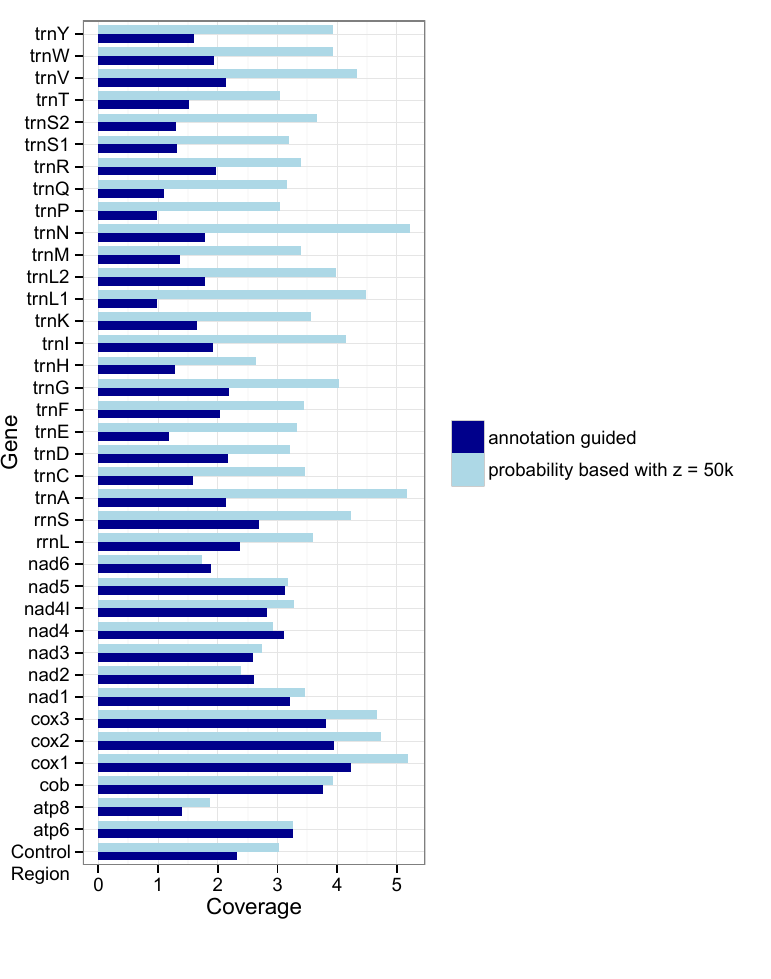
Figure 3. Coverage of genes by markers as detected with the annotation guided method and the probability based method. The coverage for a gene g is defined by the overlap of all markers with g as target gene with the annotations of g divided by the summed length of all regions annotated as g in the